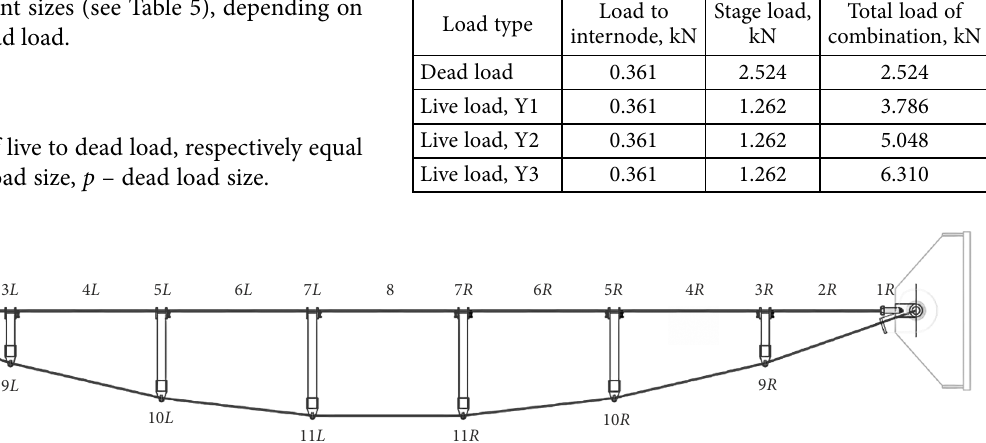
Figure 4. Schematic diagram of the experimental model, where 1, 2, 3… is number of node, L – left side, R – right side